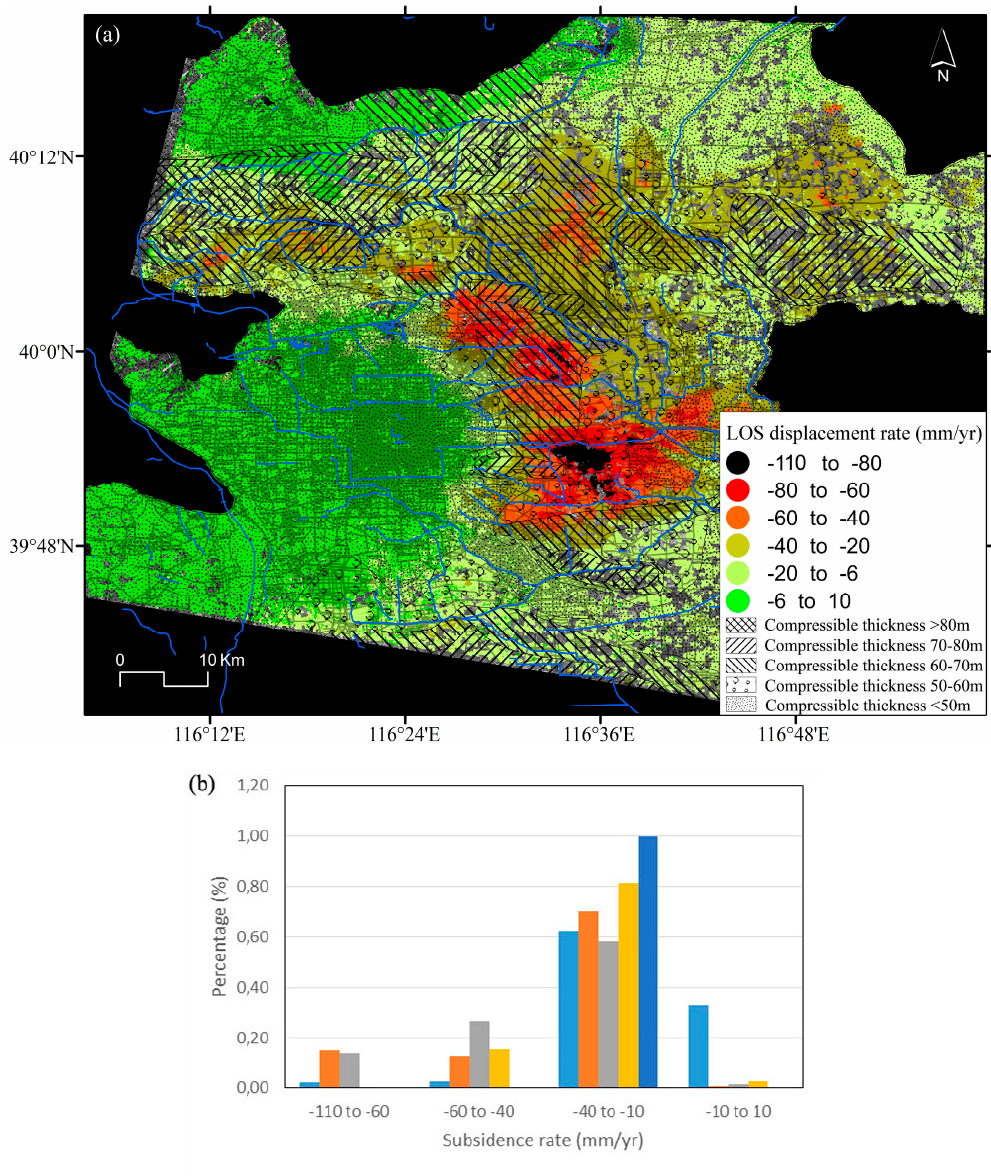
Figure 11. ( a ) Distribution of clayey layers on the study area [28]; ( b ) Statistics of InSAR-derived land subsidence rate data for the different soft soil ranges.